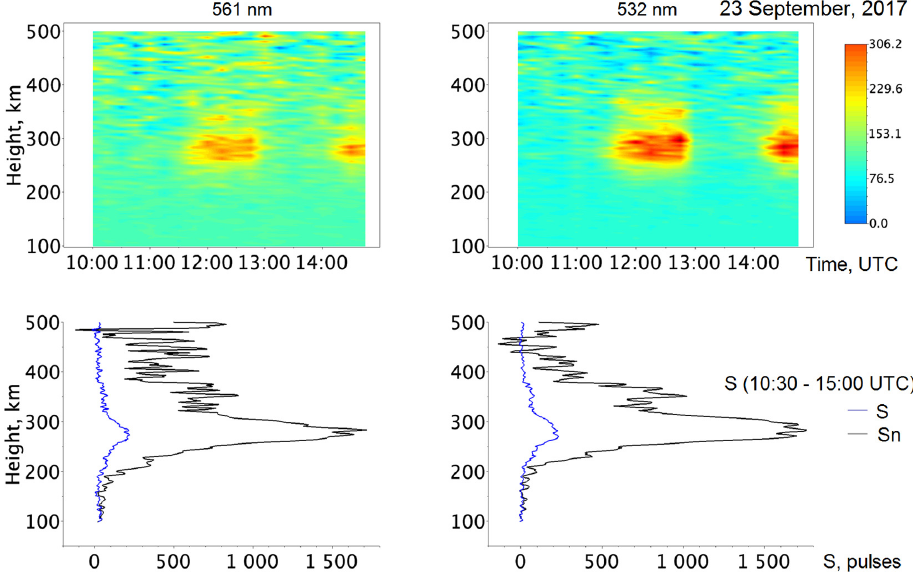
Figure 6. The same as that in Figure 5, but for 23 September 2017.